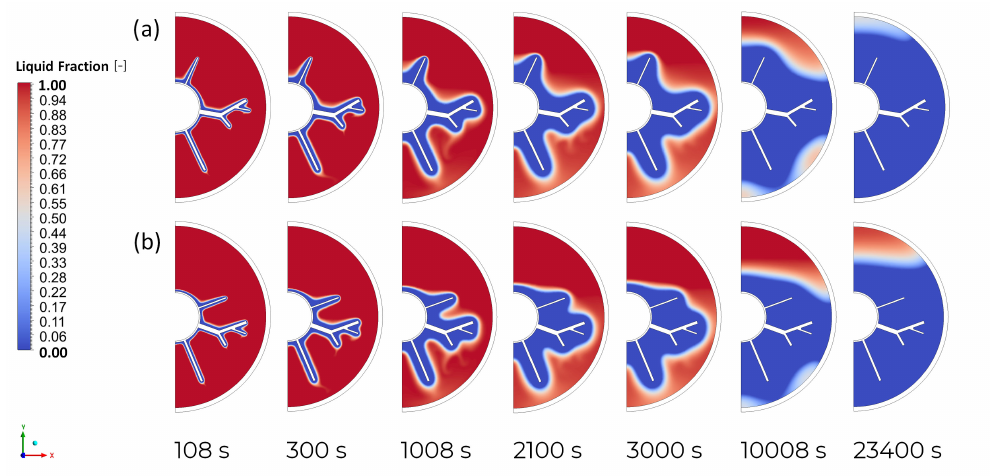
Figure 9. Liquid fraction contours during solidification for ( a ) DP No. 15, ( b ) DP No. 24.